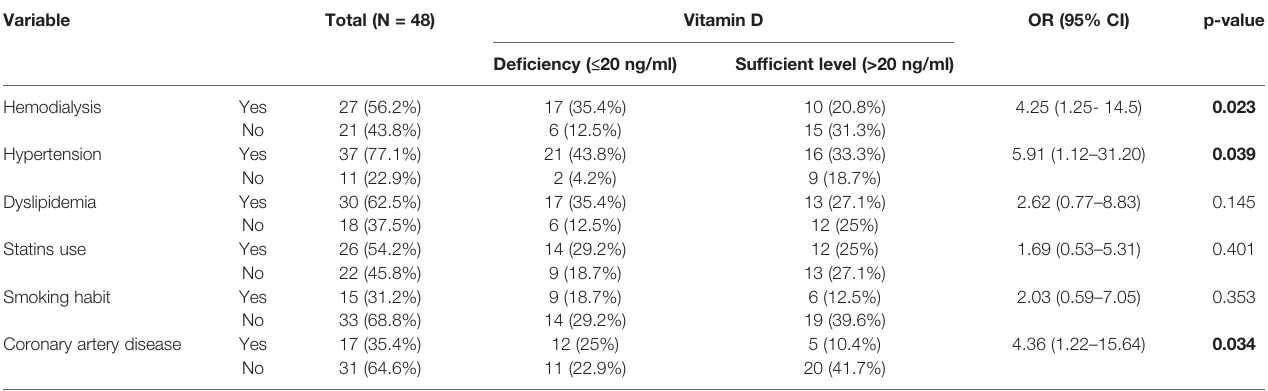
TABLE 3 | The relationships between vitamin D levels and the presence/absence of coronary artery disease, hemodialysis, main cardiovascular risk factors, and statins use. Variable